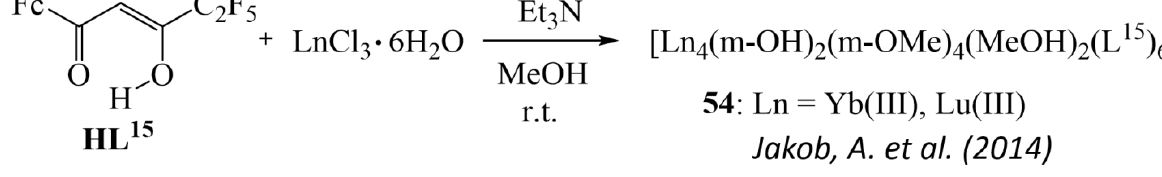
ing ligands (Figure 28).